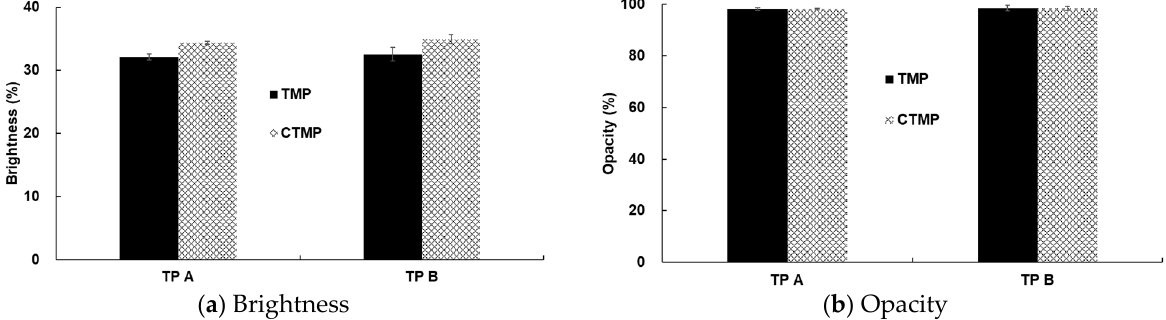
Figure 8. Brightness and opacity of TMP and CTMP prepared from the plates with distinctive pat-